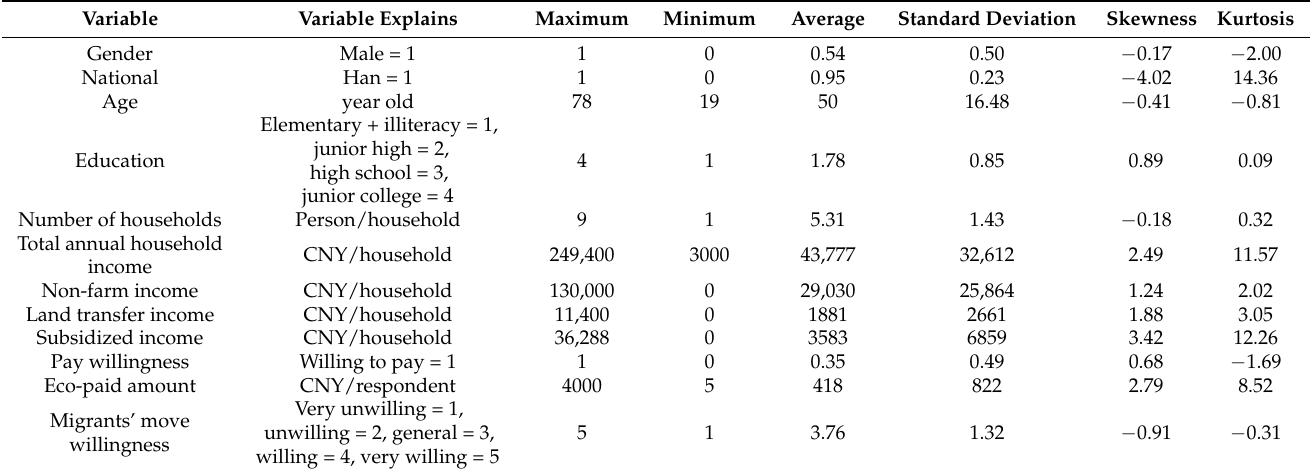
Table 1. Characteristics of surveyed